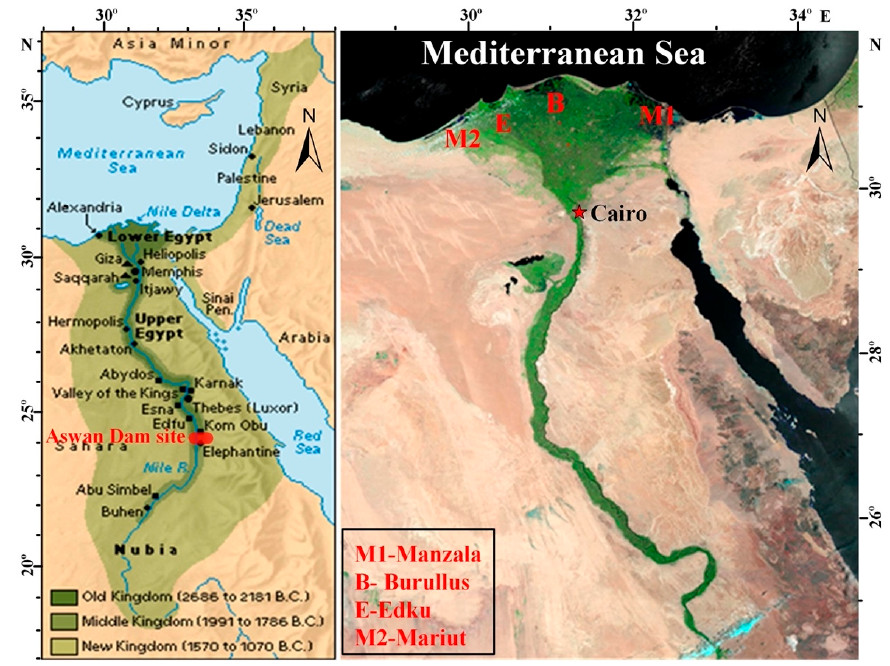
Figure 3. The Nile River basin, where Aswan dam site is shown ( left ); Lower Nile River and Nile Delta, where 4 lagoon Lakes are indicated ( right ).